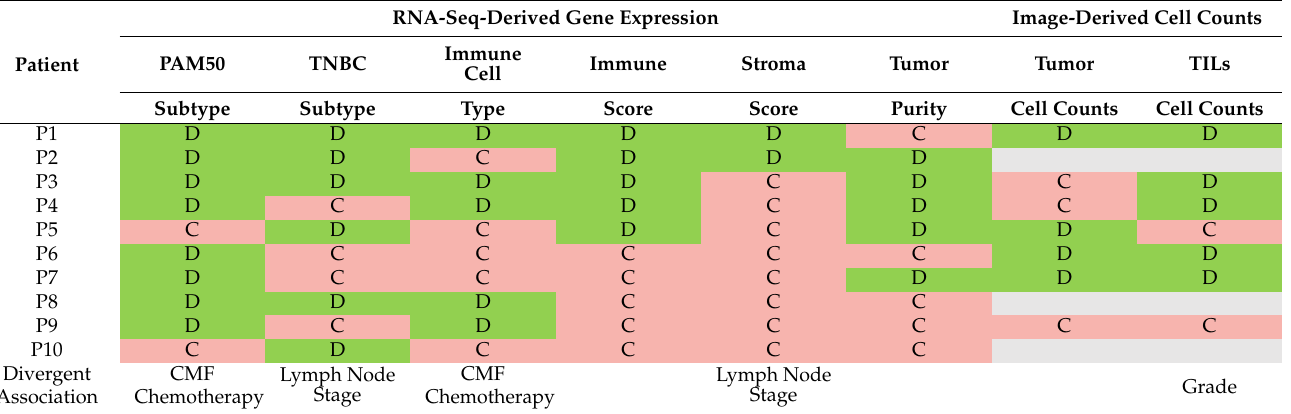
Figure 5. Summary of heterogeneity in features derived from gene expression and imaging data. According to the degree of variability in each feature, patients were stratified into patients with divergent tumors and those with convergent tumors. Table 2. Summary of the impact of regional heterogeneity in gene expression-derived and image- derived features. “C” denotes convergence (i.e., low intratumor heterogeneity among regions) and “D” denotes divergence (i.e., high intratumor heterogeneity among regions). The “Divergent Asso- ciation” row highlights patient and tumor associations with the divergent versus convergent results at p < 0.20 based on Fisher’s exact test.